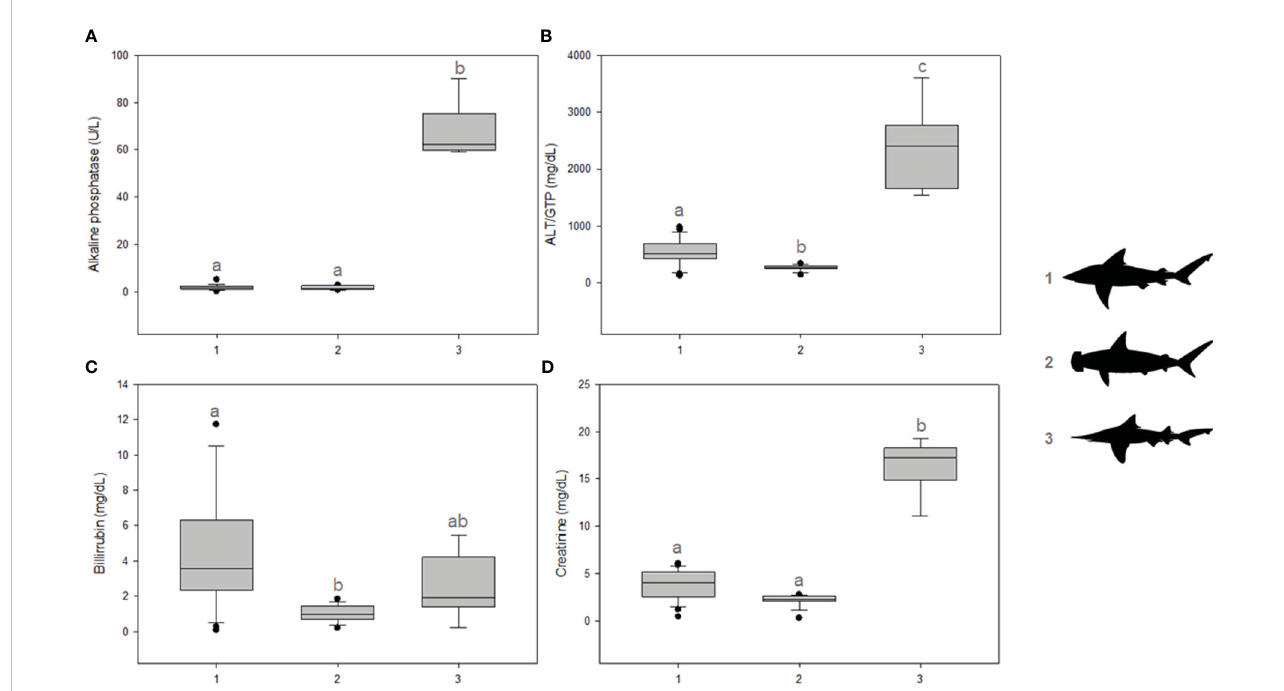
FIGURE 1 Serum markers indicating organ integrity and functionality. (A) Alkaline Phosphatase (ALP) activities; (B) Alanine transaminase (ALT) activities; (C) Bilirubin concentrations; (D) Creatinine concentrations. The shark groups are indicated in the graph by 1) Carcharhinus spp., 2) Sphyrna spp., and 3) I oxyrhynchus . Statistical differences are represented by lowercase